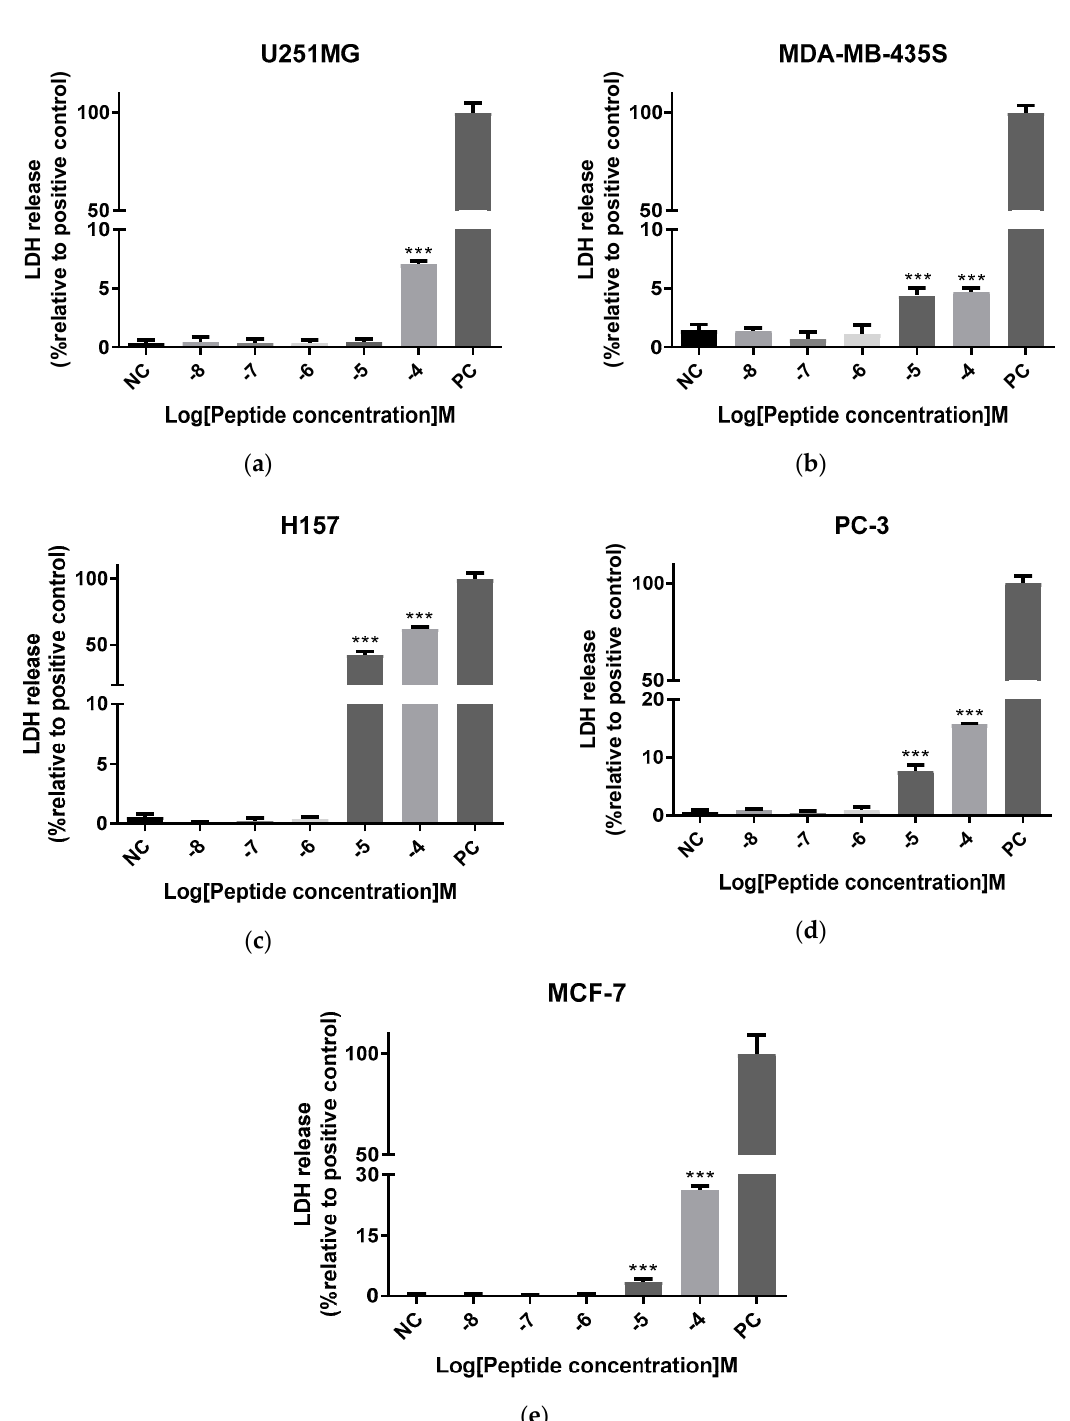
Figure 10. The effect of Der-PS4 on proliferation of human cancer cell lines: U251MG ( a ), MDA-MB- 435S ( b ), H157 ( c ), PC-3 ( d ), MCF-7 ( e ) and human dermal microvascular endothelium cell HMEC-1 ( f ) after treated with Der-PS4 for 24 h in a range of concentrations from 10 − 9 to 10 − 4 M. Negative control was acquired after incubation with serum-free culture medium. Data represent means ± SEM (stand error of the mean) of five replicates.